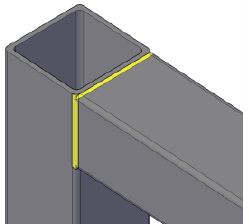
Figure 3. Beam–column joint.